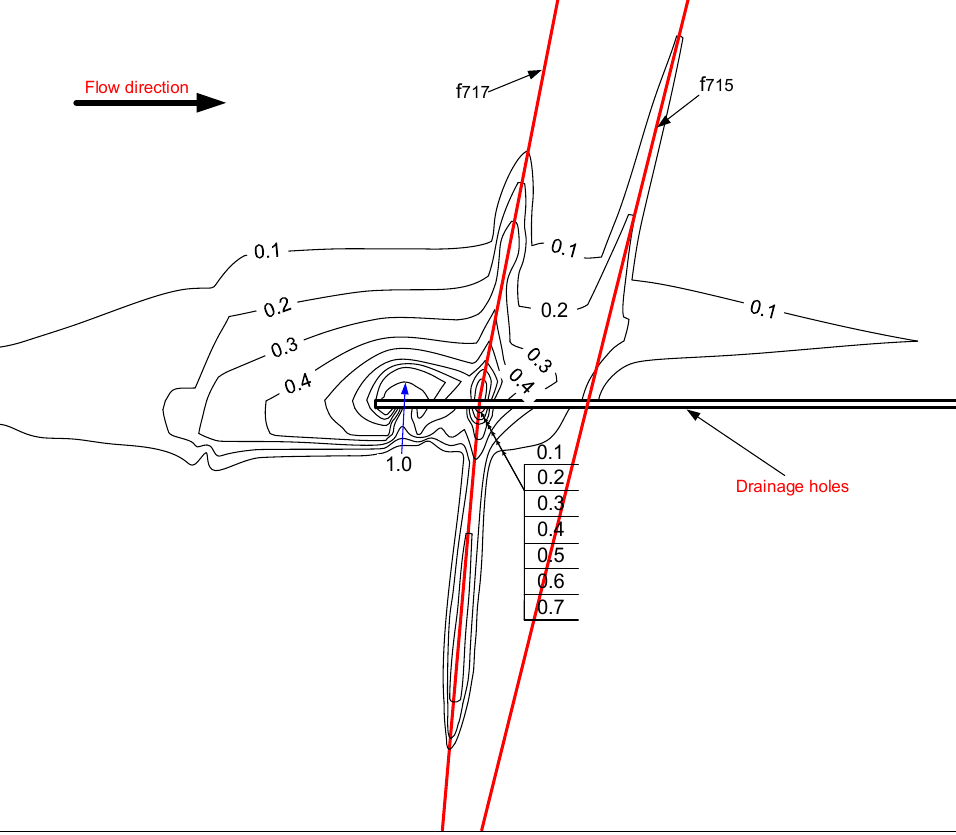
Figure 11. The F 0 contours at cross-section of the A3 drainage galleries.